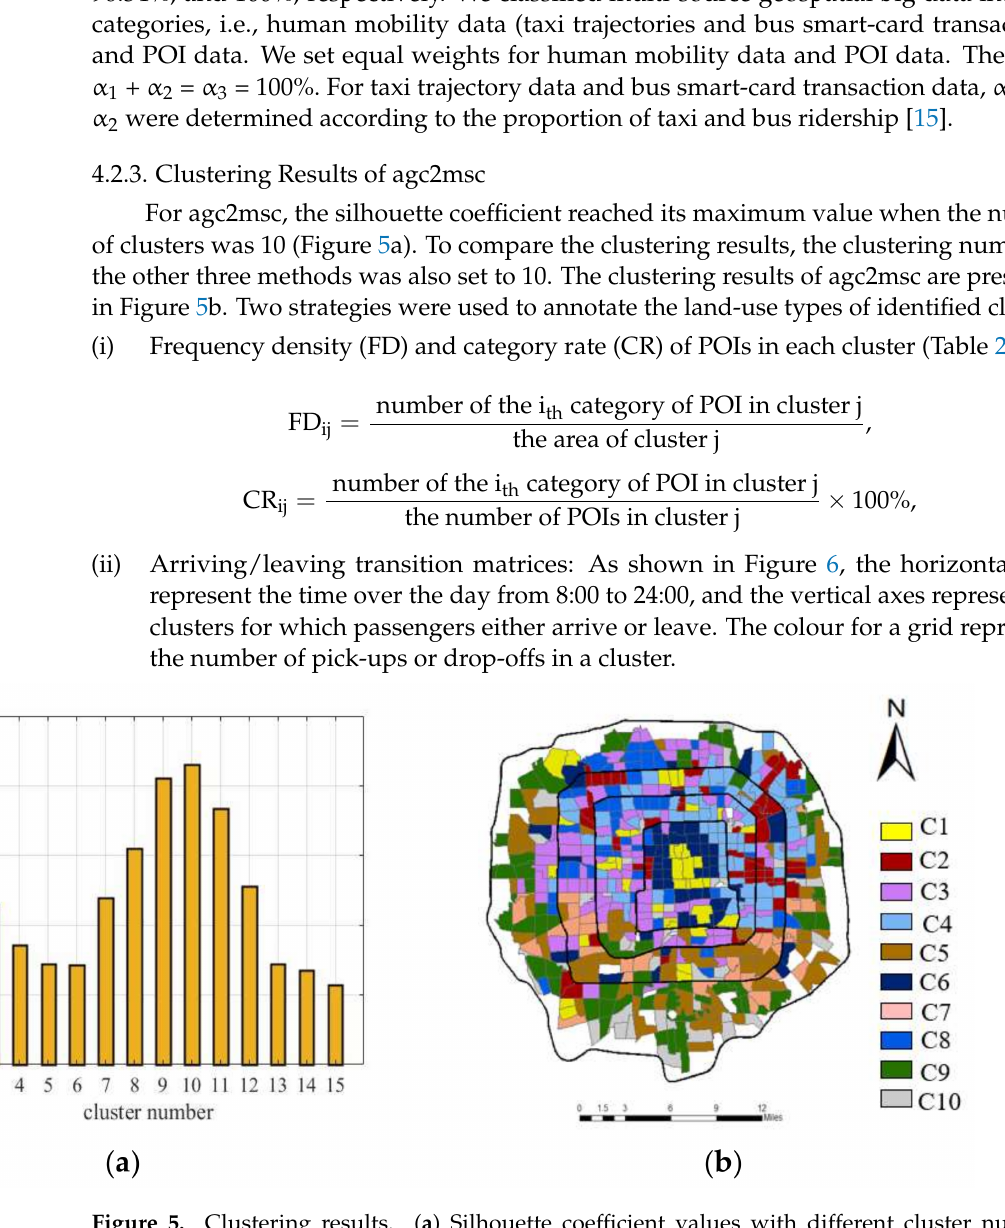
Figure 5. Clustering results. ( a ) Silhouette coefficient values with different cluster numbers; ( b ) Clustering results of the proposed method (ten